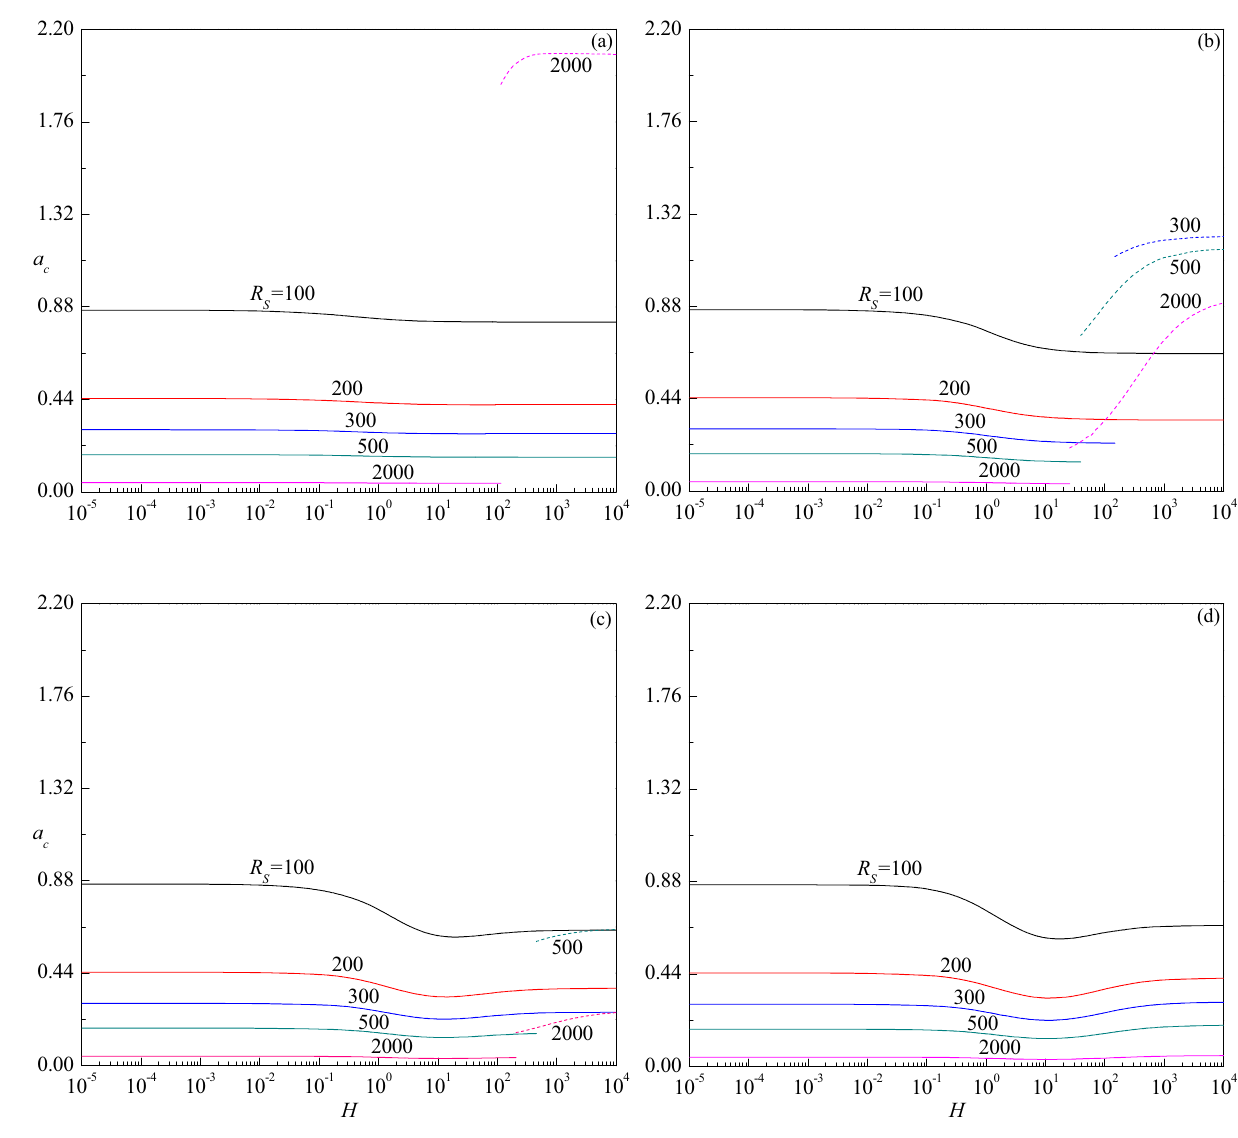
Figure 10. The variation of a c versus H for different values of R S relative to the cases ( a ) γ = 10 , ( b ) γ = 1 , ( c ) γ = 0.1 and ( d ) γ = 0.01 when Le = 2